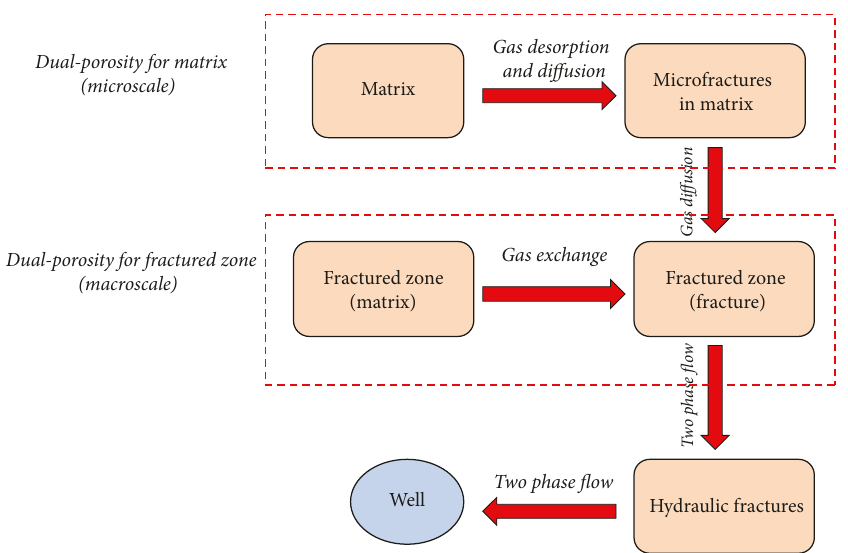
Figure 2: Flow and diffusion processes in multiscale